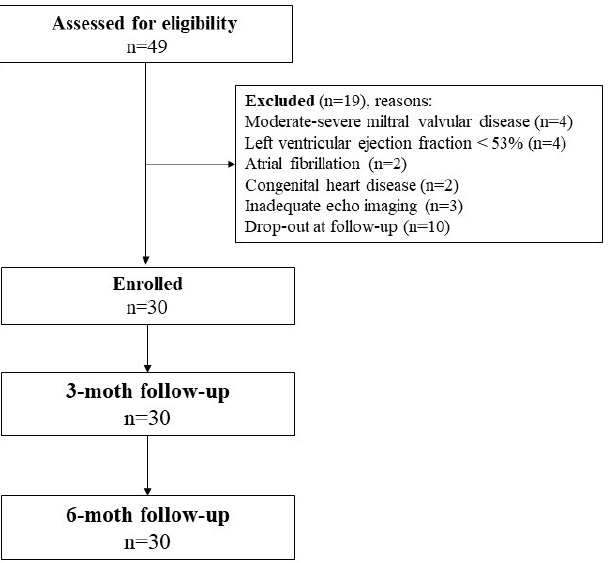
Figure 1. Patient flow and study design .